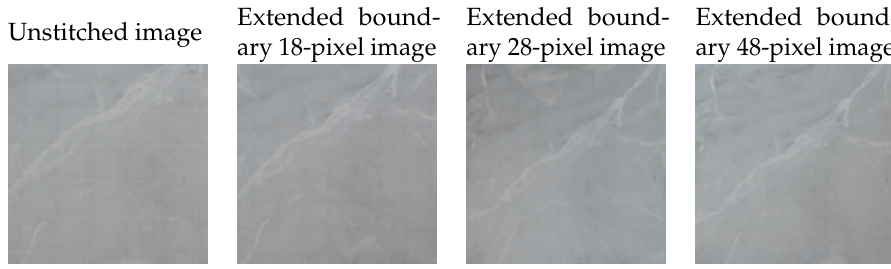
Figure 10. A comparison of the boundary value size of sititching.